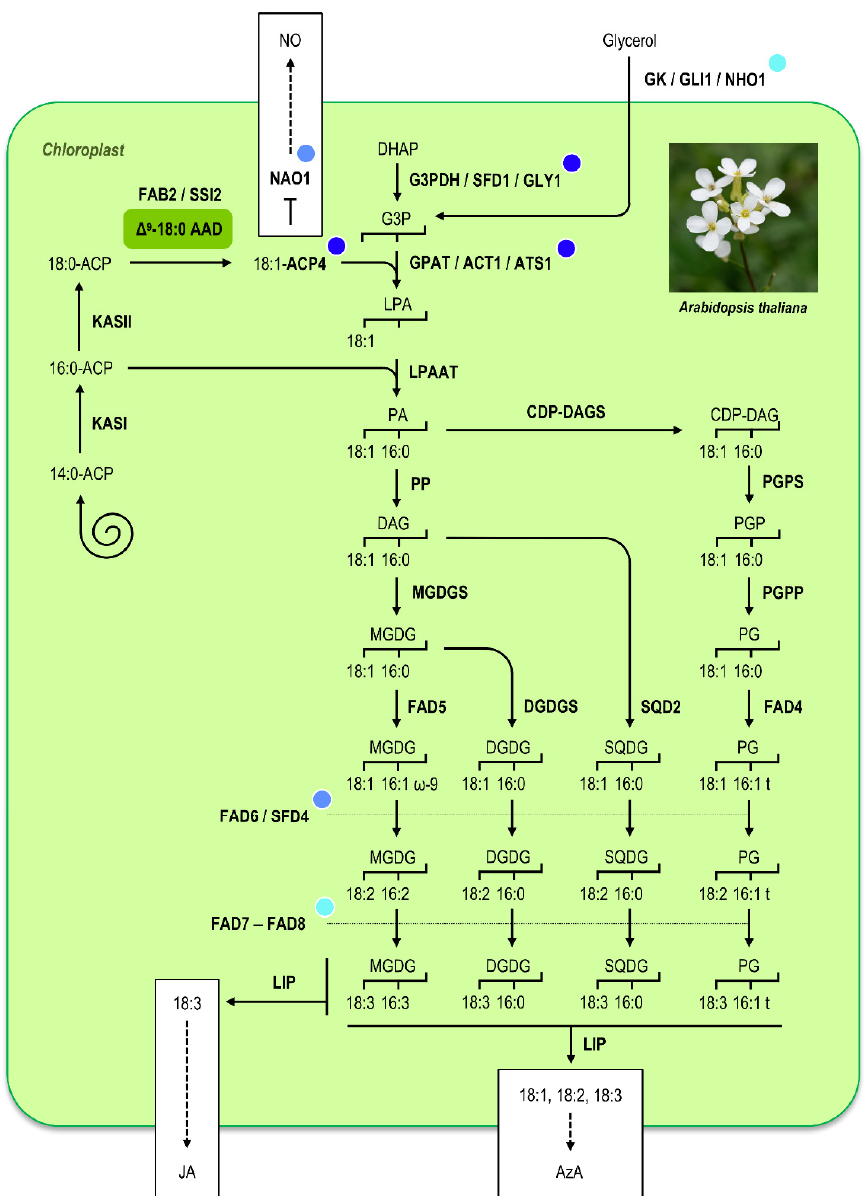
Figure 3. Lipid metabolism in the chloroplasts of Arabidopsis thaliana. The scheme depicts the different pathways involved in the biosynthesis of fatty acids and the elaboration of membrane lipids in the chloroplasts of A. thaliana . For the sake of clarity, export of fatty acids from the plastids and the eukaryotic lipid metabolic pathway have been omitted. Production of oleic acid by the ∆ 9 -stearoyl–ACP desaturase FAB2/SSI2 is highlighted in green. Blue-colored circles denote enzymatic steps whose blockage (by mutation of corresponding genes) complements the fab2 / ssi2 mutant phenotype: darker shades of blue denote full phenotypic reversion while lighter shades of blue denote partial phenotypic reversion. Lipid-derived signaling molecules (JA and AzA) and NO, whose biosynthesis is regulated by oleic acid, are presented on a white background. AAD, acyl–acyl carrier protein desaturase; ACP, acyl carrier protein; AzA, azelaic acid; CDP-DAG, cytidinediphosphate-diacylglycerol; DAG, diacylglycerol; CDP-DAGS, cytidinediphosphate-diacylglycerol synthase; DHAP, dihydroxyacetone phosphate; DGDG, digalactosyldiacylglycerol; DGDGS, digalactosyldiacylglycerol synthase; FAD, fatty acid desaturase; G3P, glycerol-3-phosphate; G3PDH, glycerol-3-phosphate dehydrogenase; GK, glycerol kinase; GPAT, glycerol-3-phosphate acyltransferase; JA, jasmonic acid; KAS, fatty acid synthase complex comprising 3-ketoacyl-ACP synthase; LIP, lipase; LPA, lysophosphatidic acid; LPAAT, 1-acylglycerol-3-phosphate acyltransferase; MGDG, monogalactosyldiacylglycerol; MGDGS, monogalactosyldiacylglycerol synthase; NAO1, NITRIC OXID ASSOCIATED1; NO, nitric oxide; PA, phosphatidic acid; PG, phosphatidylglycerol; PGP, phosphatidylglycerol-phosphate; PGPP, phosphatidylglycerol-phosphate phosphatase; PGPS, phosphatidylglycerol-phosphate synthase; PP, phosphatidate phosphatase; SQD2, UDP-sulfoquinovose:diacylglycerol sulfoquinovosyltransferase; SQDG, sulfoquinovosyldiacylglycerol. Picture credit: